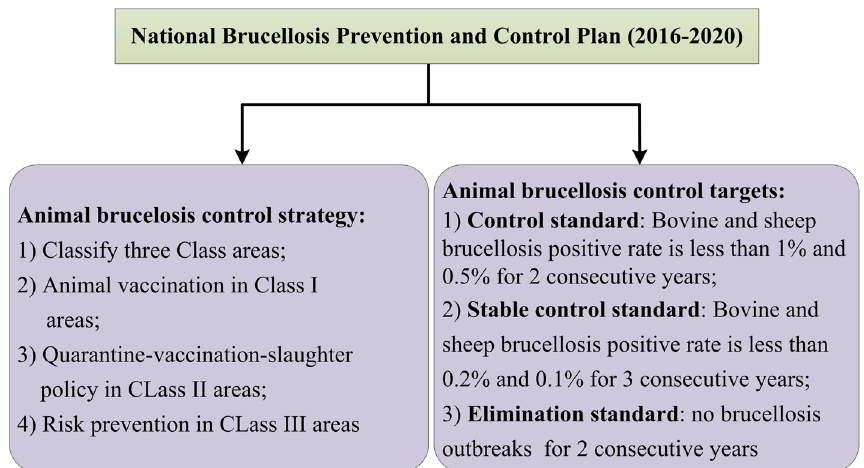
Fig. 6 Control strategy and targets of animal brucellosis in the National Brucellosis Prevention and Control Plan